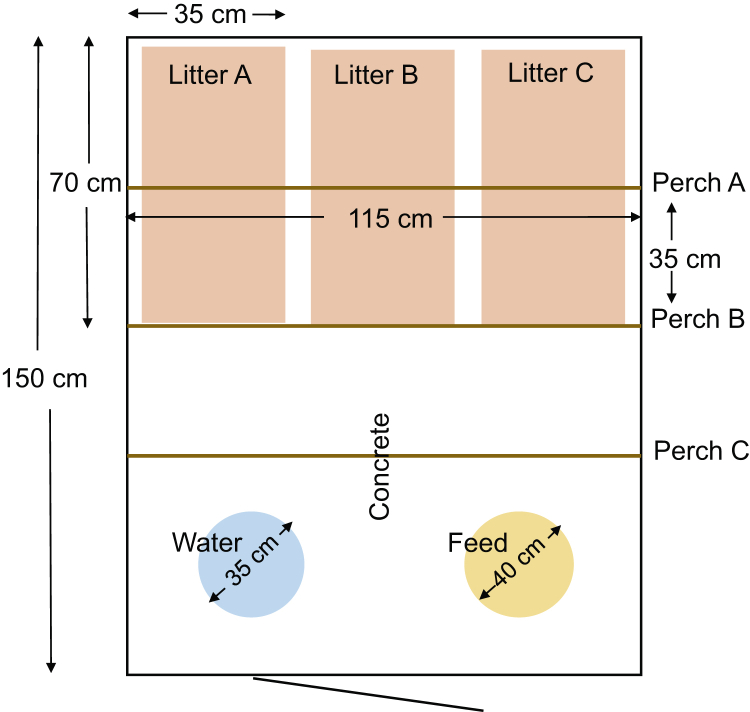
Each pen had 3 different litter types and 3 different perch types at a time, presented at locations A, B, and C. All litter and perch types were presented to all pens and at all locations during the 3-week-long test period.